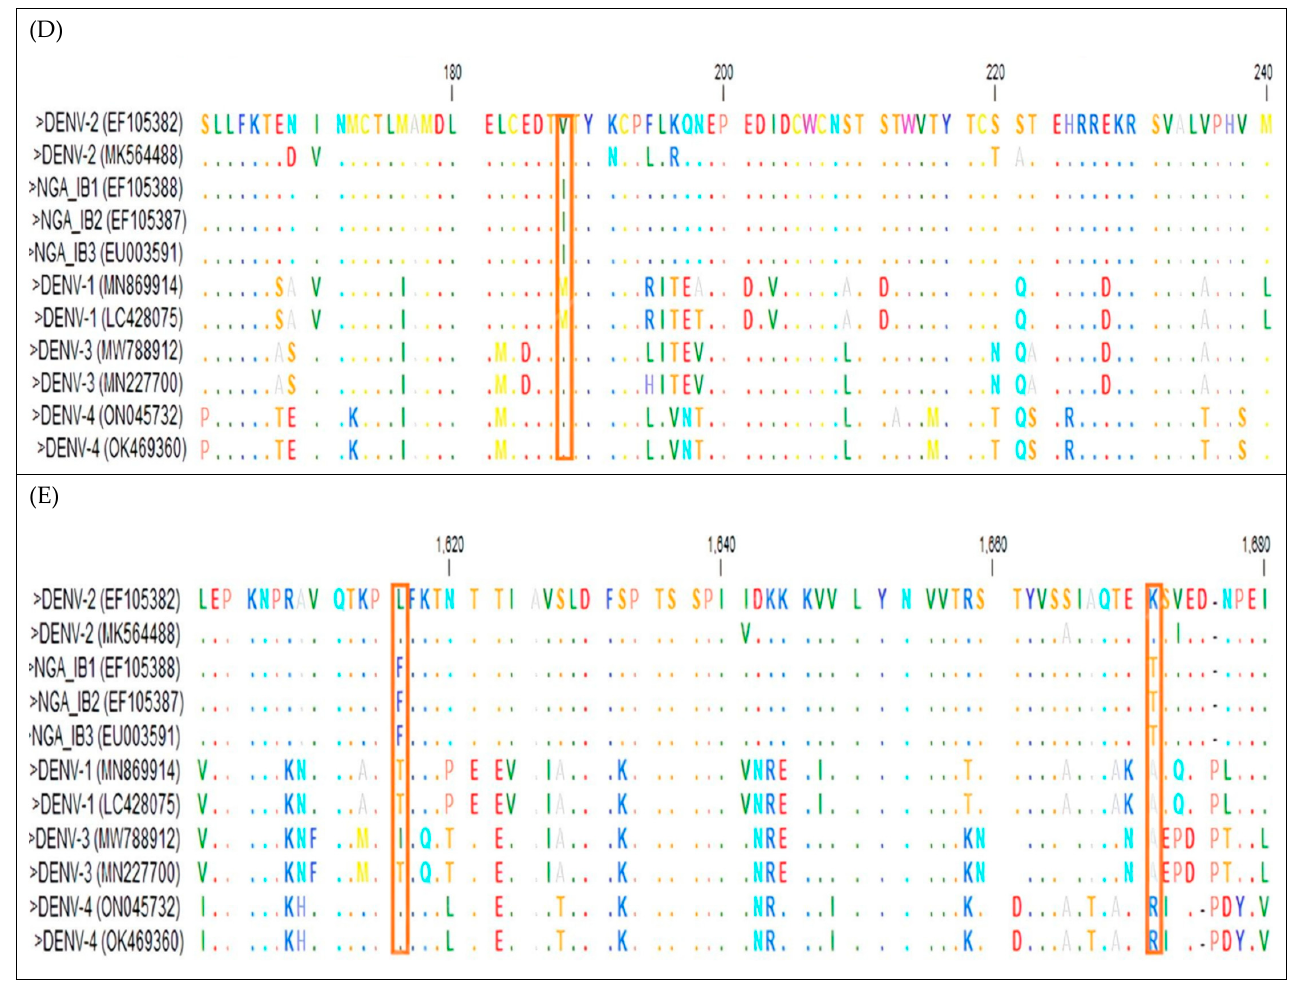
Figure 3. Multiple sequence alignment of the nucleotide sequences of ( top panel , ( A , B )) NS1, ( middle panel , ( C )) E/NSI, and ( bottom panel , ( D,E )) POLY genes of DENV-2. The highlighting indicates the position where amino acid mutations occurred in the genes of Nigerian isolates. Dots indicate positions where the gene sequences were identical to that of the consensus sequence.